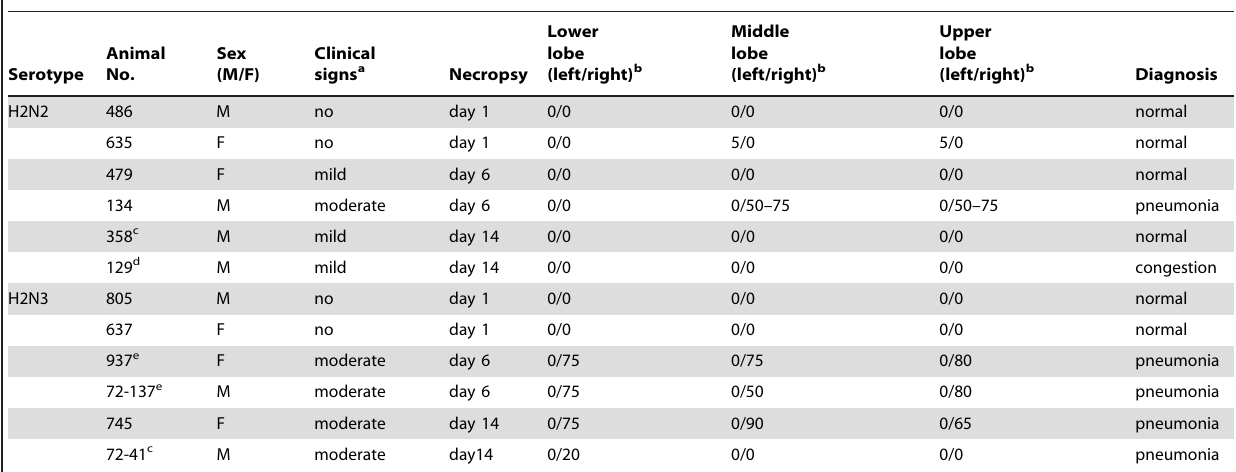
Table 1. Clinic, pathology and diagnosis.